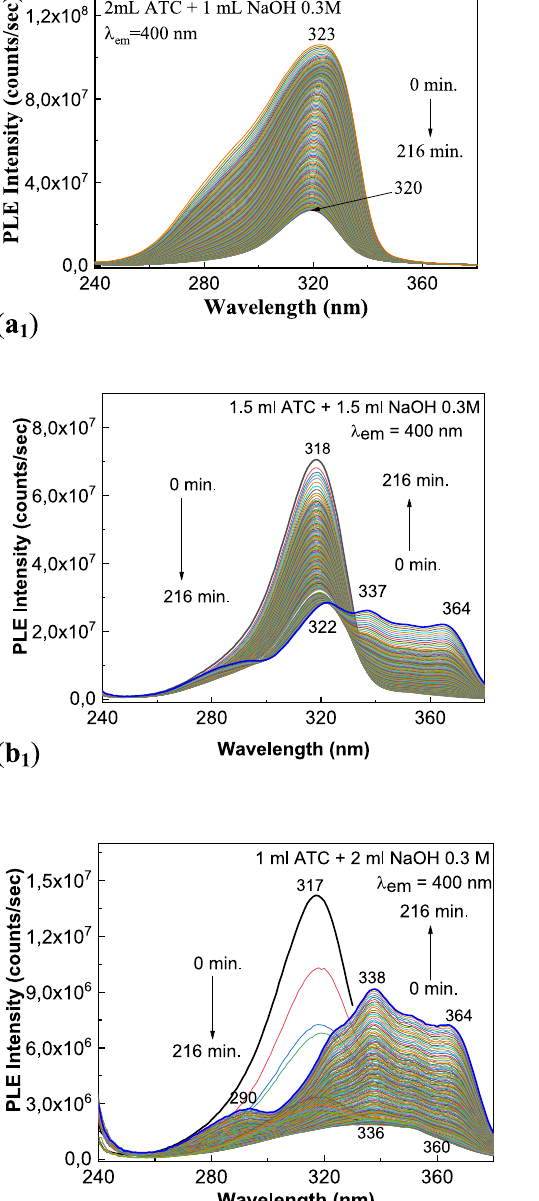
The increase of the concentration of NaOH at 1.5 M induces changes similar with those reported in Fig. 5S. Thus, in Fig. 5S one observes that in the case of the ATC interacted with NaOH 1.5 M, by the exposure to UV light, time of 216 min, takes place: (1) a variation in the intensity of the PLE band at 320–317 nm from 9.71 × 10 7 to 1.94 × 107 counts/s (Fig. 5Sa); and (2) a down-shift of the PL band from 380 to 393 nm and a decrease of the intensity from 1.29 × 10 5 to 1.86 × 10 4 counts/s (Fig. 5Sb). Such variations are also observed in the case of phar- maceutical products of the type TOR and SOR. Before reveal the influence of the alkaline medium, the photodegradation process of the aqueous TOR solu- tion is shown. Figure 4 shows the PLE and PL spectra of the aqueous solution of TOR. According to Fig. 4a, the PLE spectra show a maximum at 324 nm, whose intensity decreases from 1.34 × 10 8 to 1.01 × 10 8 counts/s, as increasing the exposure time to UV light time of 216 min The PL spectrum of the aque- ous solution of TOR is characterized by a band with the maximum at 372 nm, whose intensity decreases from 1.06 × 10 6 to 6.92 × 10 5 counts/s, as increasing the exposure time to UV light up to 216 min (Fig. 4b).